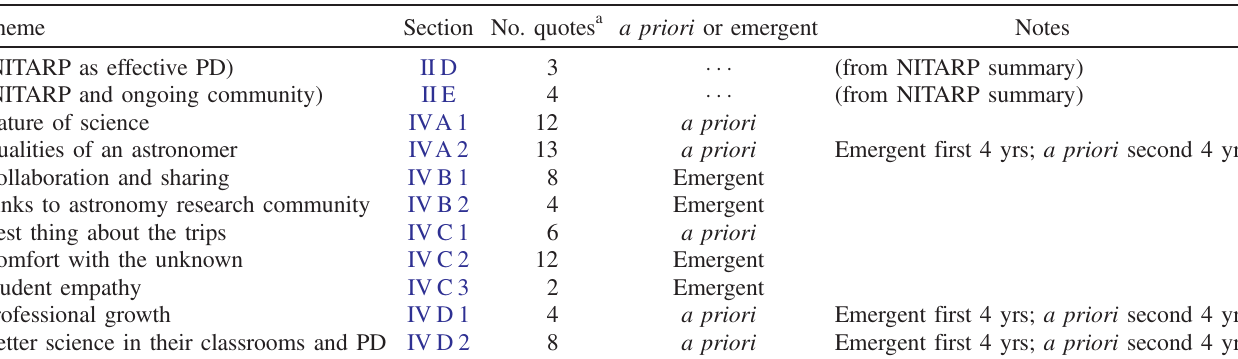
TABLE II. List of themes, section in which the theme is discussed, number of quotes included, and whether or not the theme was